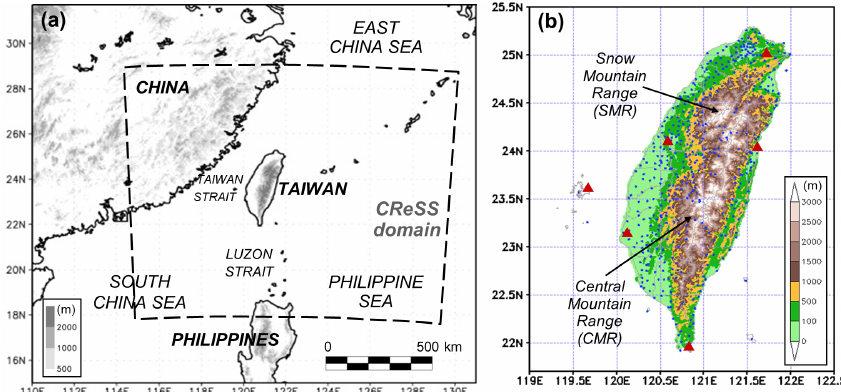
Figure 1. (a) The geography and topography (m; shading) surrounding Taiwan and the domain of 2.5km CReSS (thick dashed box) and (b) the detailed terrain of Taiwan (m; color) and the locations of rain gauges (blue dots) and land-based radars (scarlet triangles) used to produce the reflectivity composites by the Central Weather Bureau (CWB). The two major mountain ranges in Taiwan, the Central Mountain Range (CMR) and Snow Mountain Range (SMR), are marked in (b)